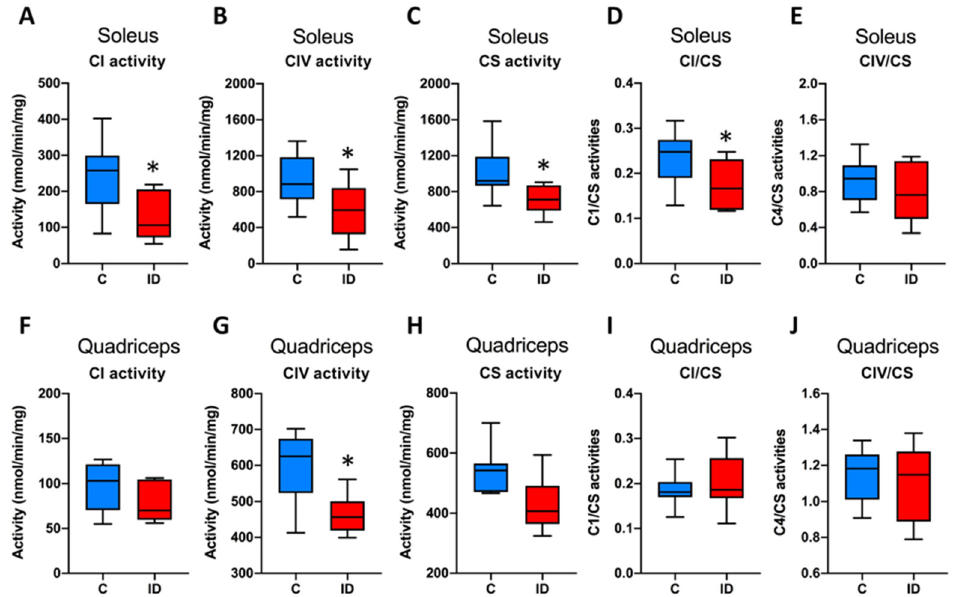
Figure 3. Mitochondrial enzymatic activities. Maximal enzymatic activities of complex I, complex IV, citrate synthase, were measured by spectrophotometry on muscle homogenates of soleus ( A – C , respectively) and quadriceps ( F – H , respectively). CI/CS and CIV/CS: specific activities of complexes I and IV normalized to the citrate synthase one ( D , E : soleus muscle; I , J : quadriceps). C (blue boxes), control group; ID (red boxes), ID group; N = 8 in each group. Box-plots represent medians, interquartile ranges and upper and lower values according to Tukey’s method. * p < 0.05 compared with control group.